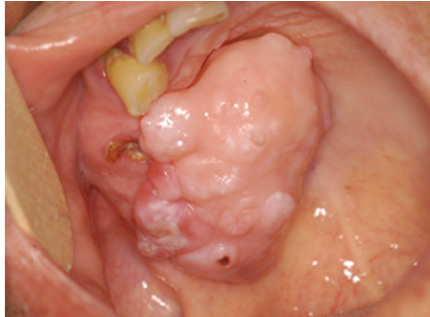
Figure 1: Clinical aspect of the soft tissue chondroma. The lesion appears as a nodular mass, approximately measuring 6 cm in its larger size, localized on the palatal side of the edentulous ridge.